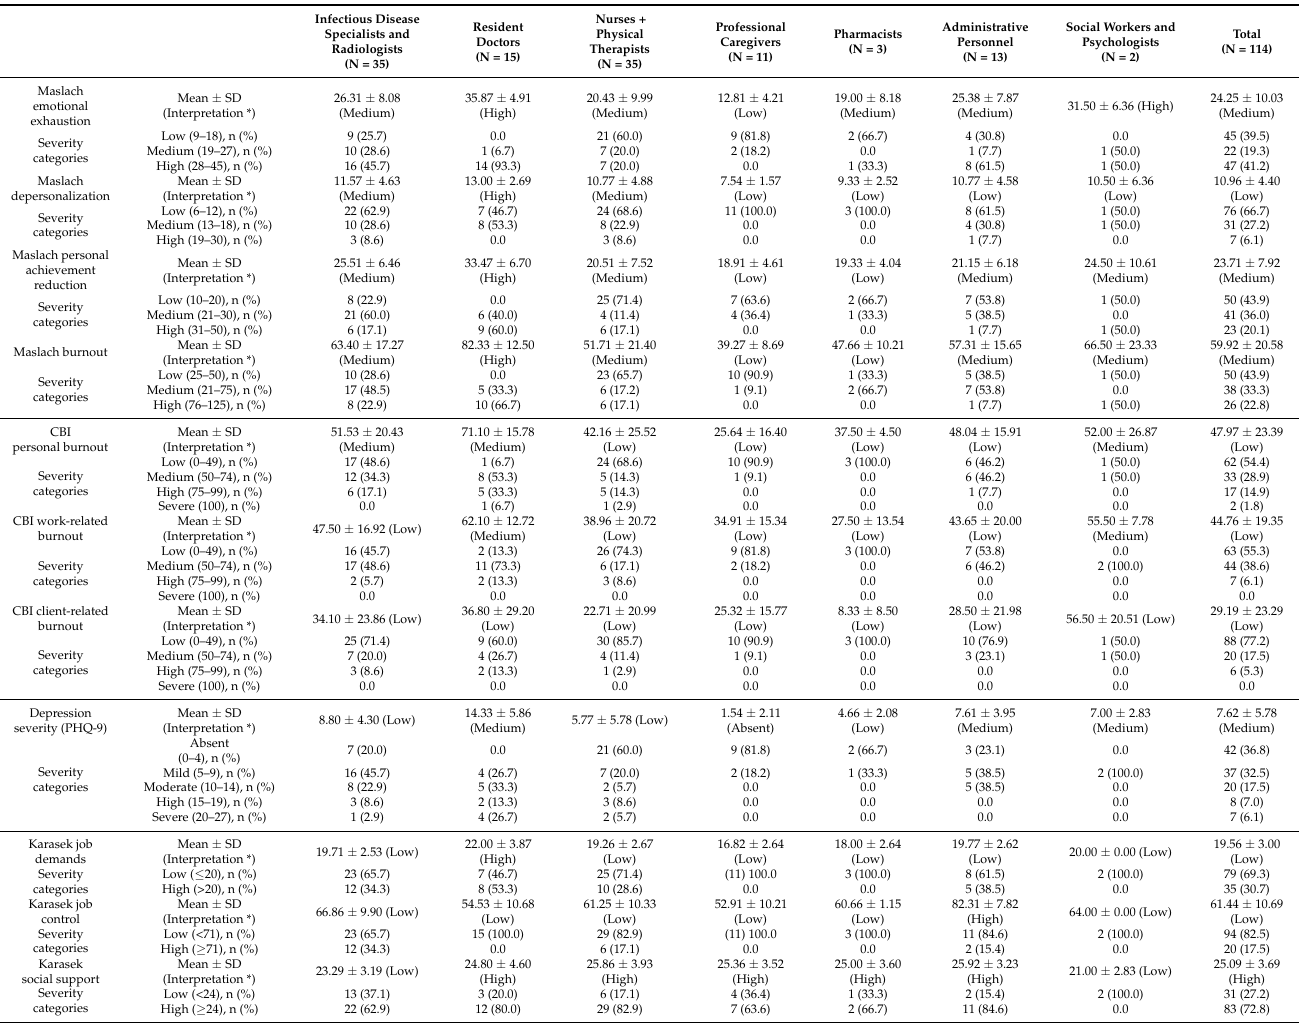
Table 3. Burnout, depression, and Karasek stressors by personnel category and percentage of people by severity